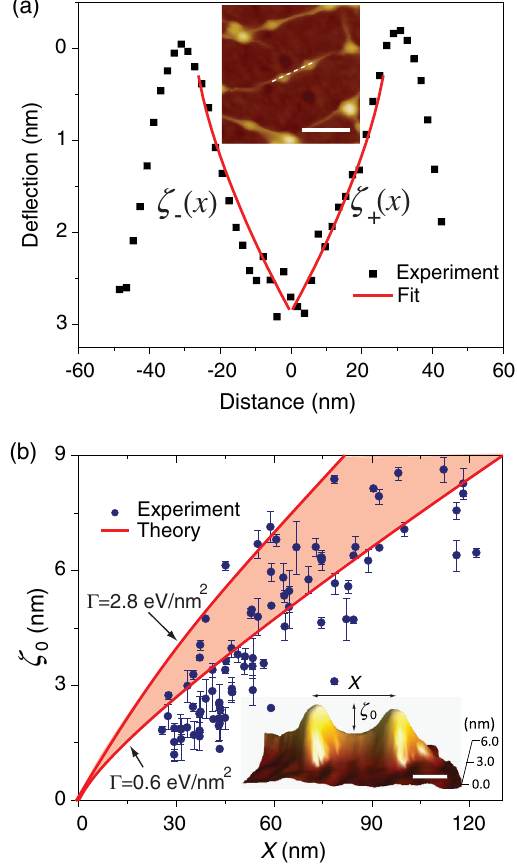
FIG. 3. (a) Profile of the wrinkle along the white dotted line in the AFM image shown in the inset. The scale bar in the inset is 50 nm. The solid red lines are theoretical expectations. (b) The as a function of the wrinkle length. The maximum deflection (cid:4) 0 due to the height error bar indicates the uncertainty of (cid:4) 0 difference between the protrusions. We choose wrinkles formed between protrusions where the height differences are less than 10%. The area shaded in red is the theoretical prediction for the with X for (cid:1) ¼ 0 : 6 – 2 : 8 eV = nm 2 . The inset is a scaling of (cid:4) 0 typical AFM image of the wrinkles formed between the two protrusions. The scale bar is 20 nm.